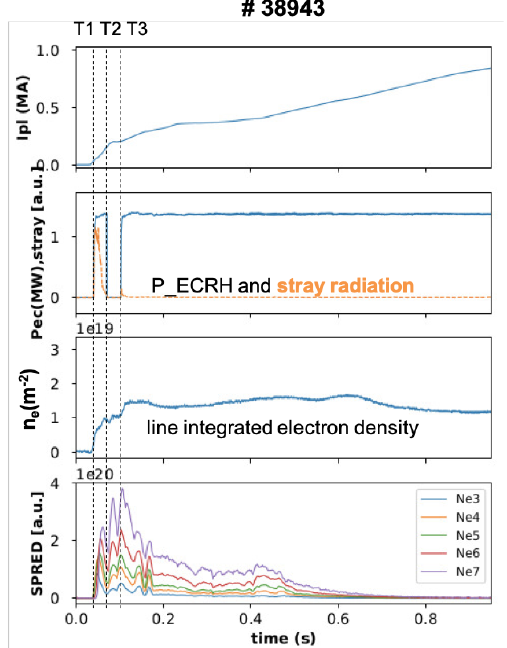
Figure 1. AUG #38943: Overview of EC-X2 assisted burn- through experiment: plasma current, EC power from 40 ms (T1) to 70 ms (T2) and stray radiation, line averaged electron density n e by interferometry and SPRED signal of NeIII up to NeVII levels. Ne / D: 7%; B tor : 2.4 T